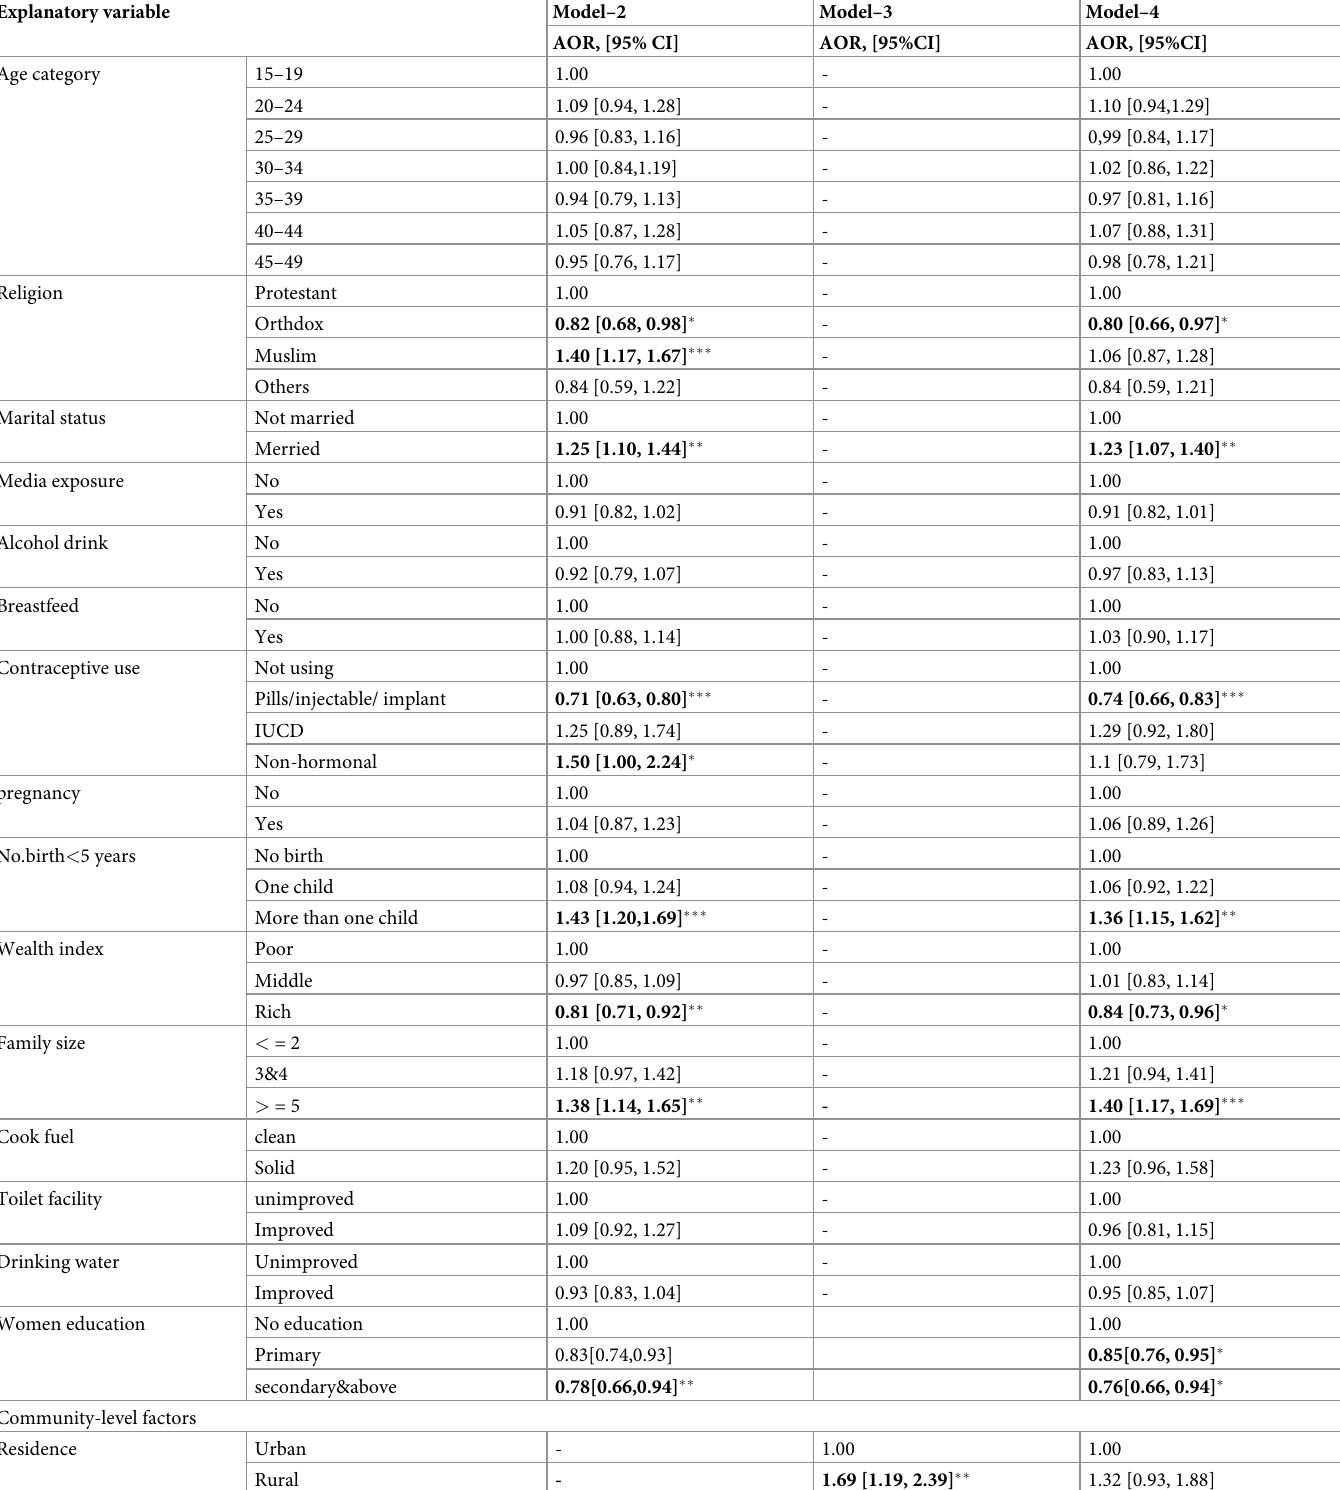
Table 3. Multi-level analysis factors associated with anemia among reproductive-age women in Ethiopia, from 2016